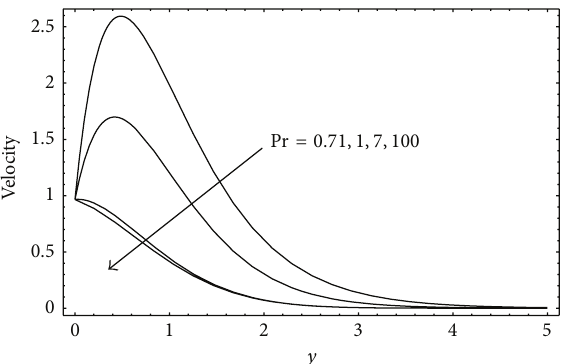
Figure 4: Velocity profiles for different values of Pr when 𝑡 = 0.5, 𝑅 = 2, Gr = 2, Gm = 1, Sc = 0.78, 𝛾 = 1 , and 𝜔 = 𝜋/6 .